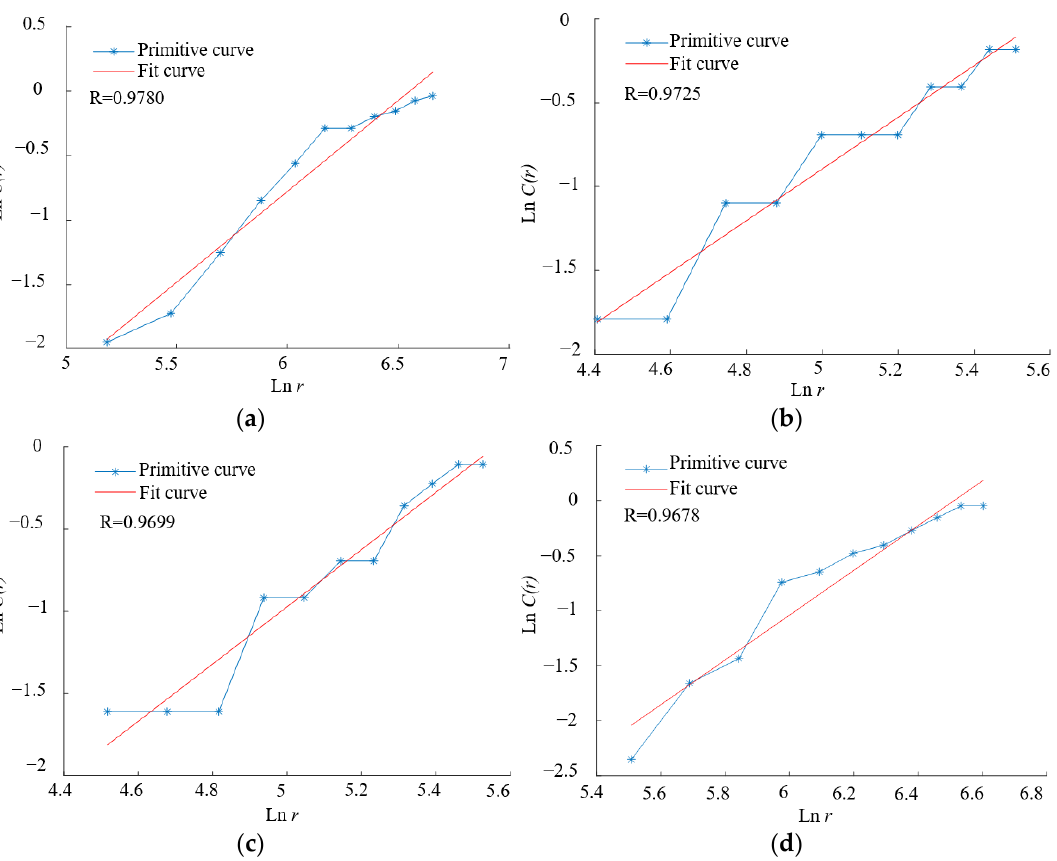
Figure 8. Double logarithmic relationship of AE events of the limestone. ( a ) The limestone without a rockburst tendency; ( b ) the limestone with a weak rockburst tendency; ( c ) the limestone with a medium rockburst tendency; and ( d ) the limestone with a strong rockburst tendency.